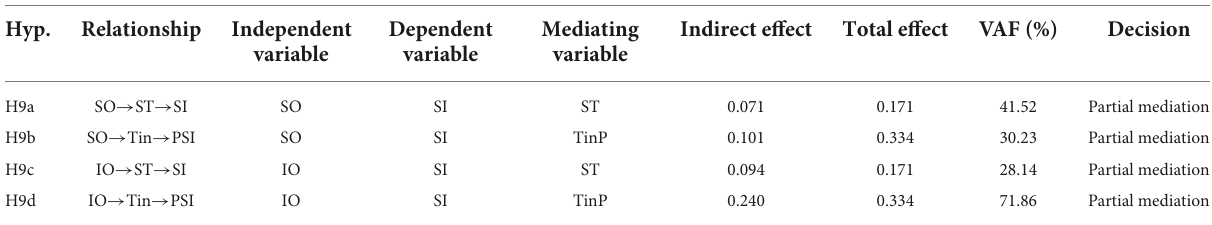
TABLE 7 Variance accounted for (VAF) of the mediating variables (satisfaction and trust in platform).